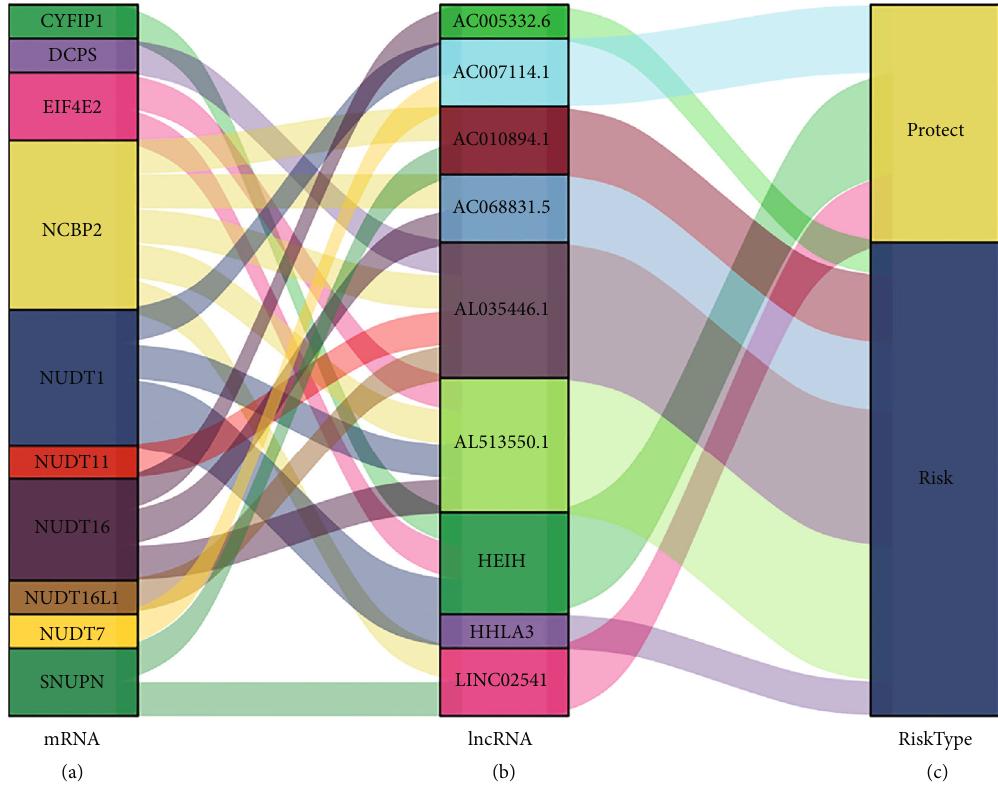
Figure 2: The Sankey diagram showed the risk pro fi le of nine m7G-related prognostic lncRNAs. The blocks represent (a) the m7G-related prognostic mRNAs, (b) the m7G-related prognostic lncRNAs, and (c) the risk types of